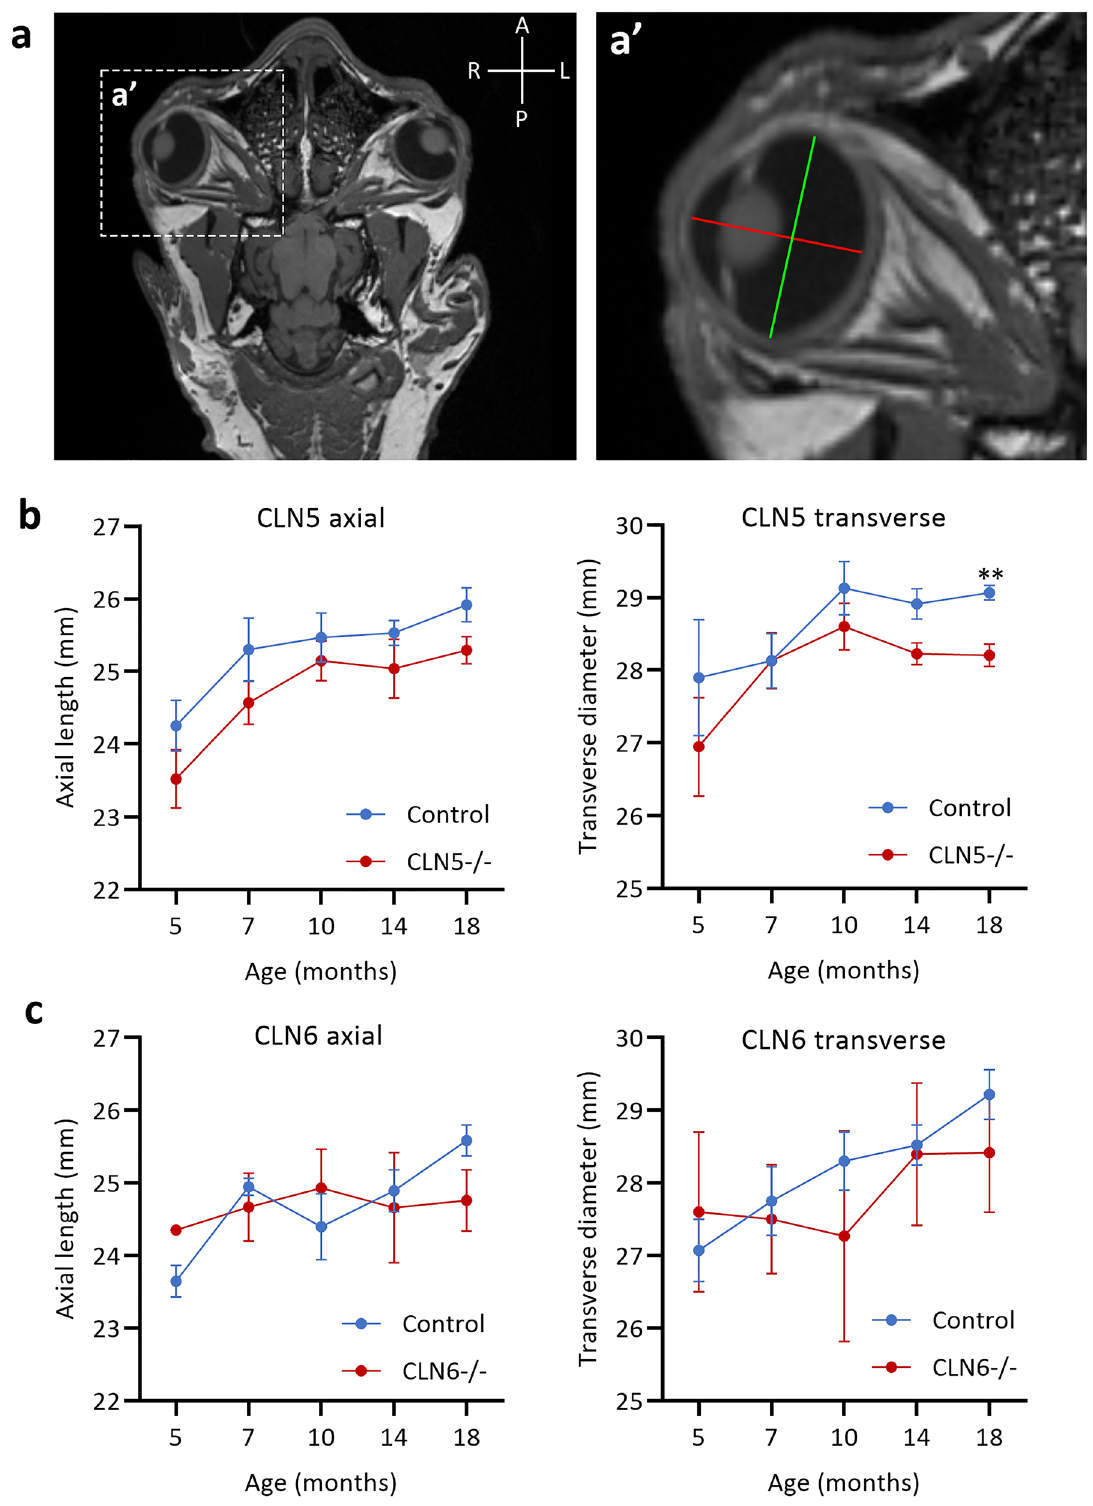
Figure 1. Eye globe dimensions in healthy and NCL affected sheep. ( a ) Axial MR image of sheep head at the level of the eyes. Dashed box indicates zoomed image ( a’ ). ( a’ ) Axial MR image of the eye globe indicating how measurements for axial length (mm; red line) and transverse diameter (mm; green line) were obtained. ( b ) Mean ± SEM eye axial length and transverse diameter measurements in healthy (Control, n = 3, blue) and CLN5 affected (CLN5 −/− , n = 4, red) Borderdale sheep. **indicates p < 0.001. ( c ) Mean ± SEM eye axial length and transverse diameter measurements in healthy (Control, n = 4, blue) and CLN6 affected (CLN6 −/− , n = 3, red) South Hampshire